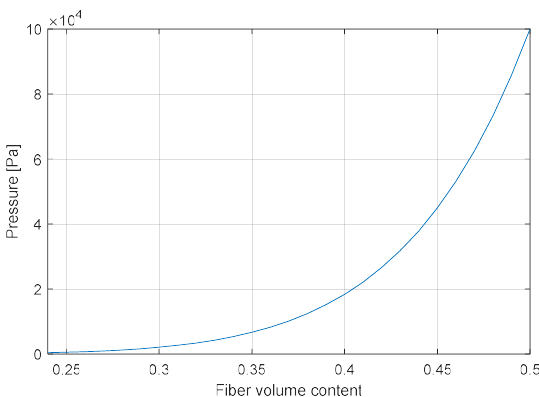
Figure 13. Compaction curve used in VARI simulation.